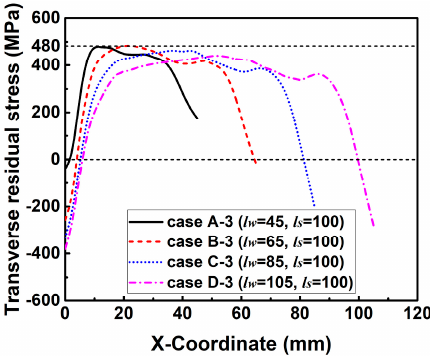
Figure 22. Transverse residual stress distribution along line 3 in cases of group 3.